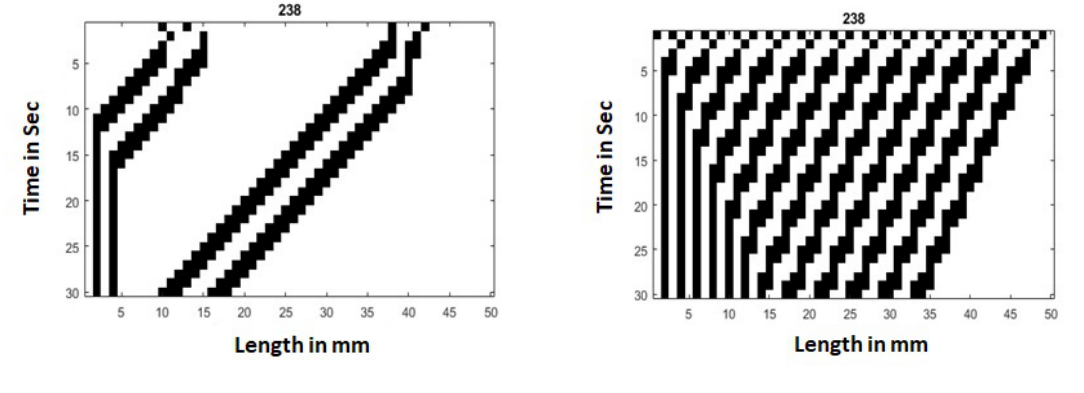
Fig. 4. Pressure perturbations in coupled nephron